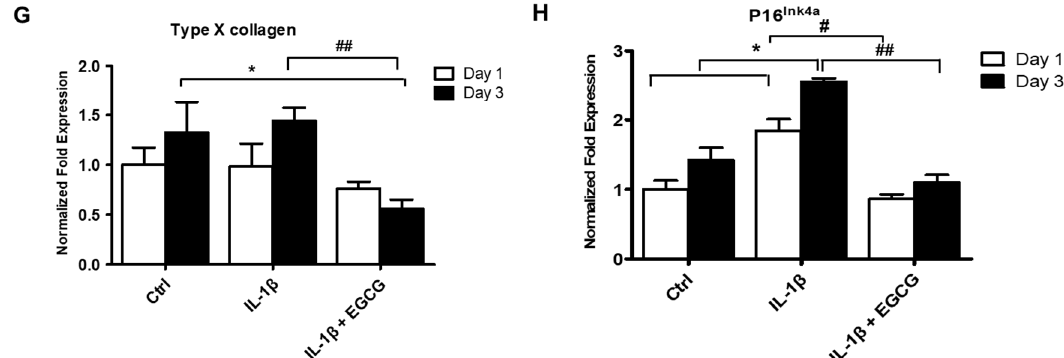
Figure 2. EGCG increased aggrecan and Col II deposition and suppressed MMP-13, IL-1, COX-2, ALP, Col X, p16 Ink4a expression. Chondrocytes were pretreated with IL-1 β (10 ng/mL) for 48 h and then treated with EGCG (10 µ M). The cells were collected at 24 and 72 h after EGCG treatment, and aggrecan, Col II, MMP-13, IL-1, COX-2, ALP, Col X, and p16 Ink4a mRNA expression levels were evaluated by RT-qPCR. ( A , B ) The mRNA expression of aggrecan ( A ) and Col II ( B ) were significantly suppressed after IL-1 β stimulation and rescued after EGCG treatment at 72 h. ( C – H ) The mRNA expression of MMP-13 ( C ), IL-1 ( D ), COX-2 ( E ), ALP ( F ), Col X ( G ), and p16 Ink4a ( H ) were significantly increased after IL-1 β stimulation and reduced after EGCG treatment. The experiments were repeated at least three times, with similar results. All data are represented as the mean ± SE (n = 8 in each group; * p < 0.05 and ** p < 0.01 versus the control group; # p < 0.05 and ## p < 0.01 versus the IL-1 β -treated group).